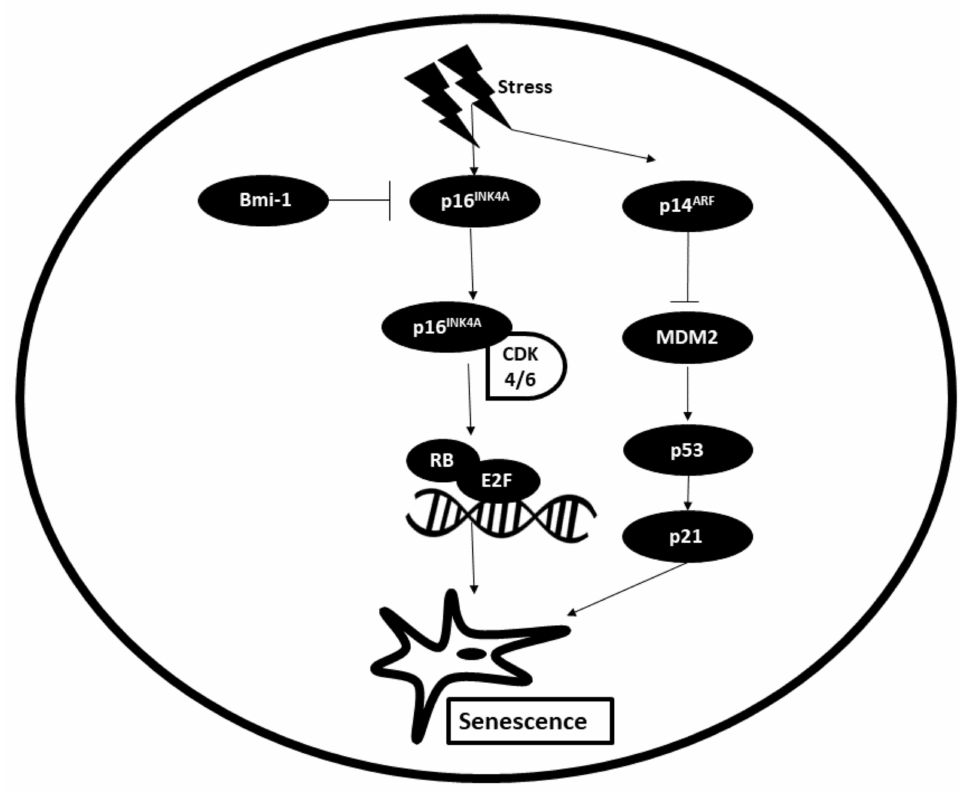
Figure 6. The main regulators of the senescence pathway. Bmi-1: B-cell-specific Moloney murine leukemia virus integration site 1; RB: Retinoblastoma; CDK: Cyclin-dependent kinase; MDM2: Mouse double minute 2 homologue.